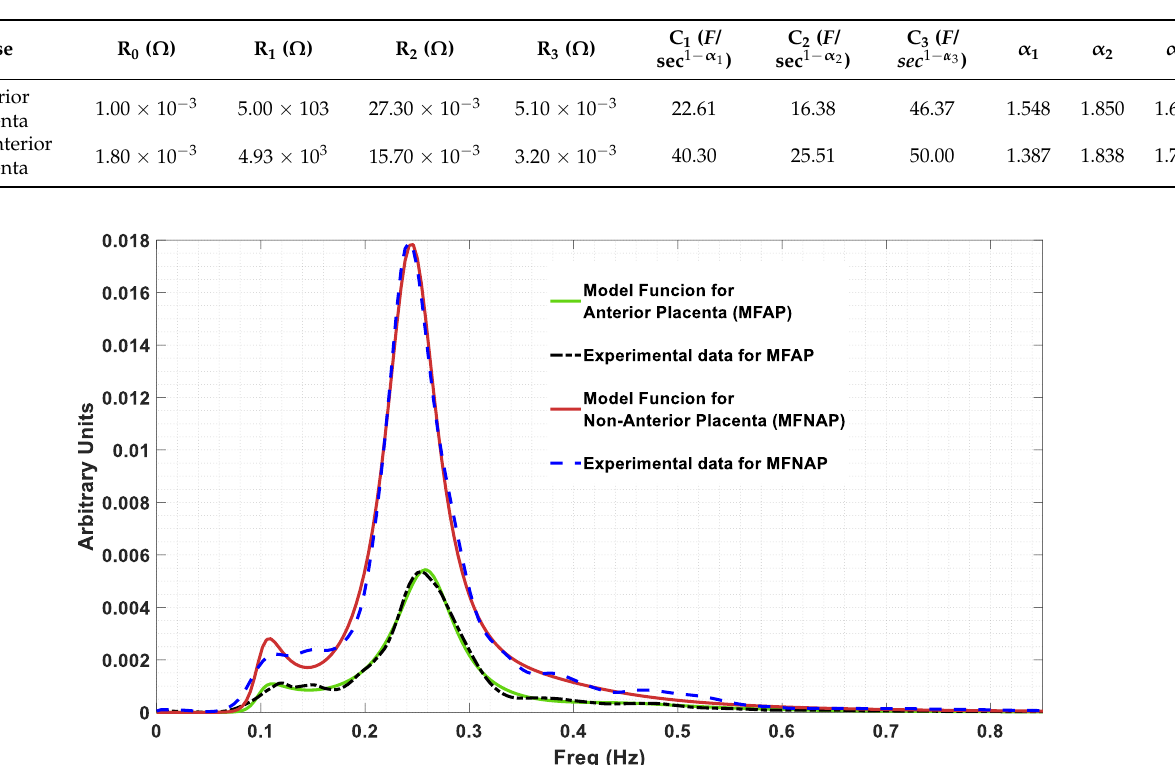
Figure 5. Model function for anterior placenta (MFAP, green colour) and the model function for non-anterior placenta (MFNAP, red colour). The experimental data spectra for MFAP (black colour) and the MFNAP (blue colour) are represented.